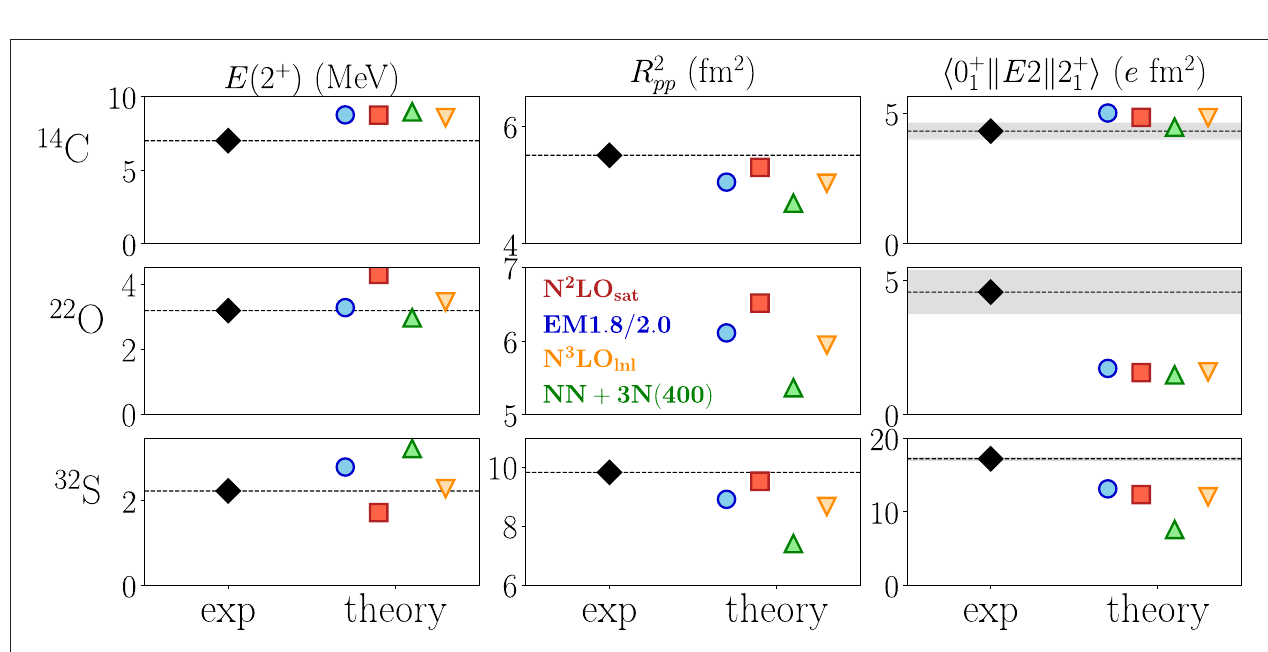
FIGURE 9 | (A) Calcium charge radii from MR-IMSRG(2) calculations with NNLO sat The shaded area indicates uncertainties from basis convergence. Black bars and orange circles indicate experimental data [ 195, 227]. (B) Mirror charge radius difference of 36 Ca and 36 S vs. the slope of the symmetry energy, L , at nuclear saturation, for the EM λ/3 interactions (symbols as indicated in the legend), compared to Skyrme functionals (solid circles) and Relativistic Mean Field models (crosses). The band indicates the experimental result from the BECOLA facility at NSCL. See reference [228] for details.